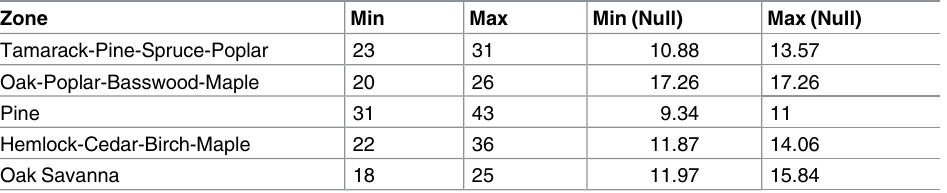
Table 3. Spatial distance to novelty—modeled as a binomial—from remnant forests (forests within the first 25th percentile of nearestneighbor distances). The null model uses permutation(n = 100) where quantilesare resampledwithout